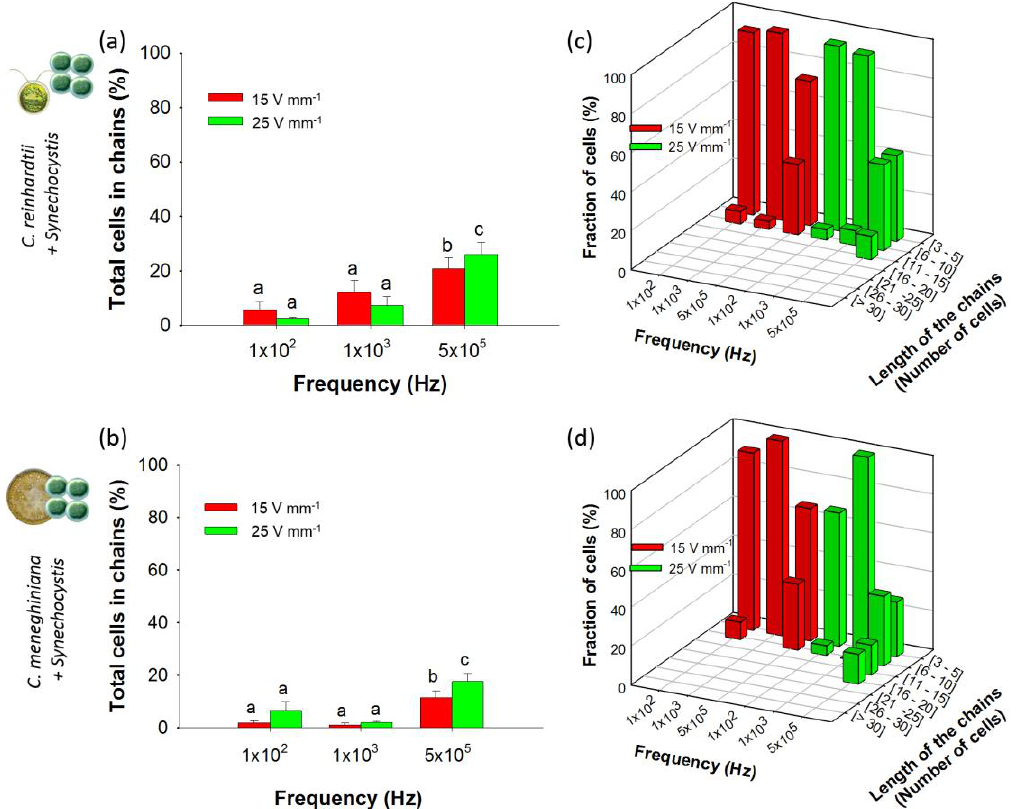
Figure 5. Chaining efficiency and structure of mixed chains (1:10) at 15 and 25 V·mm −1 and at 100 Hz, 1 kHz and 500 kHz after 5 min of AC field application. Histograms represent the total percentage of cells in chains for: ( a ) C. reinhardtii + Synechocystis sp.; and ( b ) C. meneghiniana + Synechocystis sp. 3D histograms represent the fraction of cells in mixed chains of different lengths for: ( c ) C. reinhardtii + Synechocystis sp.; and ( d ) C. meneghiniana + Synechocystis sp. Different letters indicate significant differences between the measurements obtained by one-way ANOVA and the Student–Neumann–Keuls method ( p < 0.05). Concentrations of C. reinhardtii and C. meneghiniana : 2.5 × 10 6 cells·mL −1 ; Synechocystis sp. concentration: 2.5 × 10 7 cells·mL −1 .